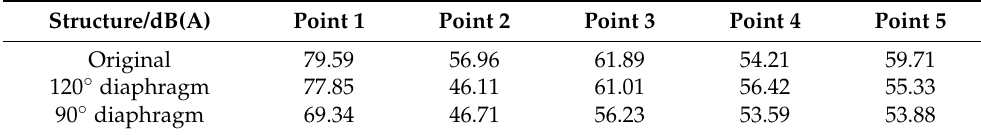
Table A1. The experimental test and measurement